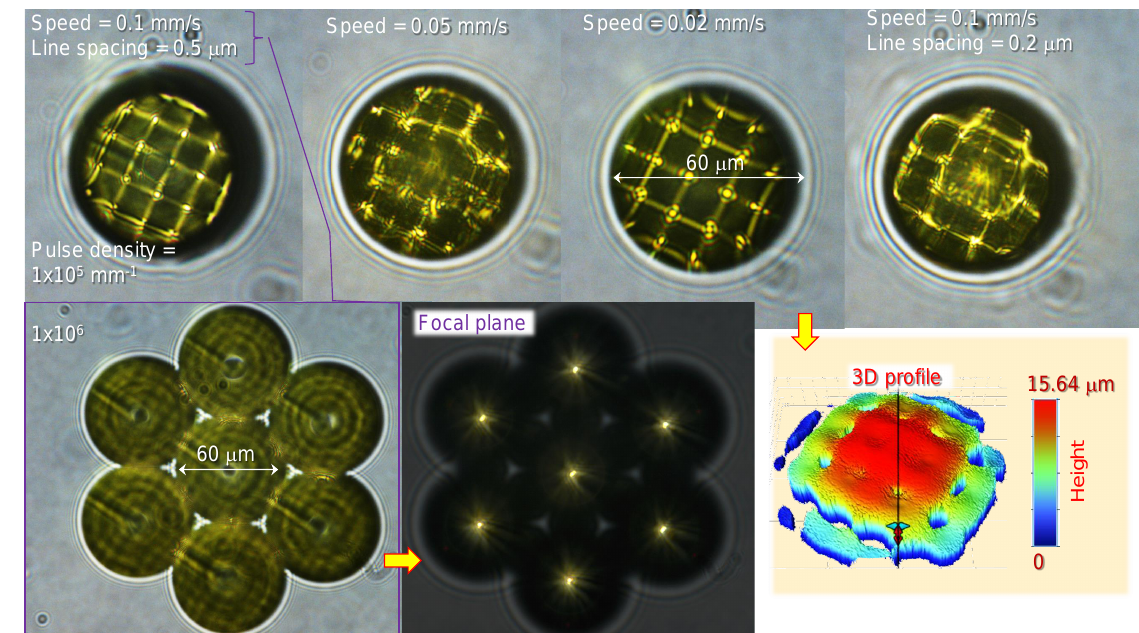
Figure A1. Optical images of microlenses polymerised at different scanning speeds, line spacings between neighbouring lines, and linear pulse densities. Polymerisation of the outer shell was carried out by concentric fs-DLW from larger-to-smaller diameters. The top-row microlenses were made at the same pulse density of 10 5 /mm. The MLA was written at a 0.1 mm/s scan speed, with a line spacing of 0.5 µ m (hatching), and a pulse density of 10 6 /mm (pulse-to-pulse separation on the sample was 0.5 nm); see text for